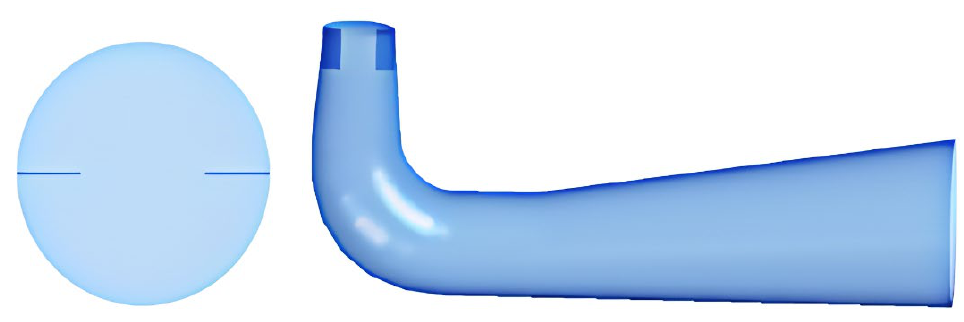
Figure 12. Schematic diagram of diversion plate [61].